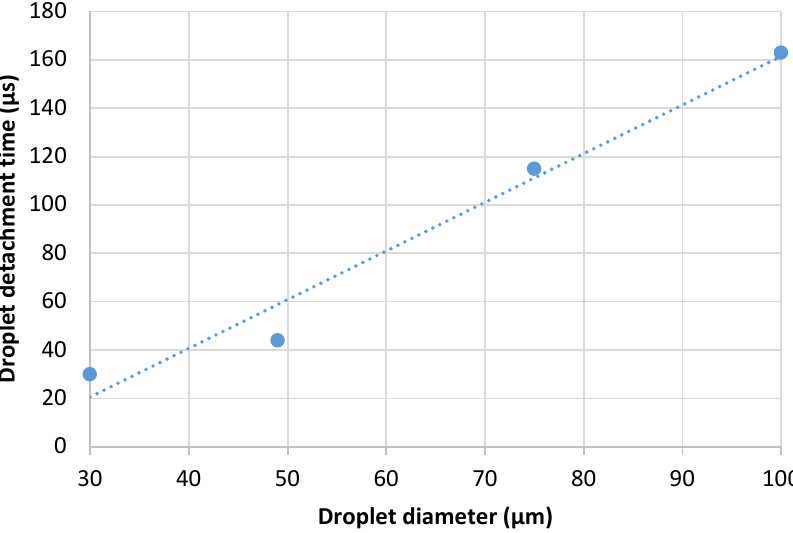
Figure 8. Time interval from boundary contact to droplet detachment as a function of droplet diameter.